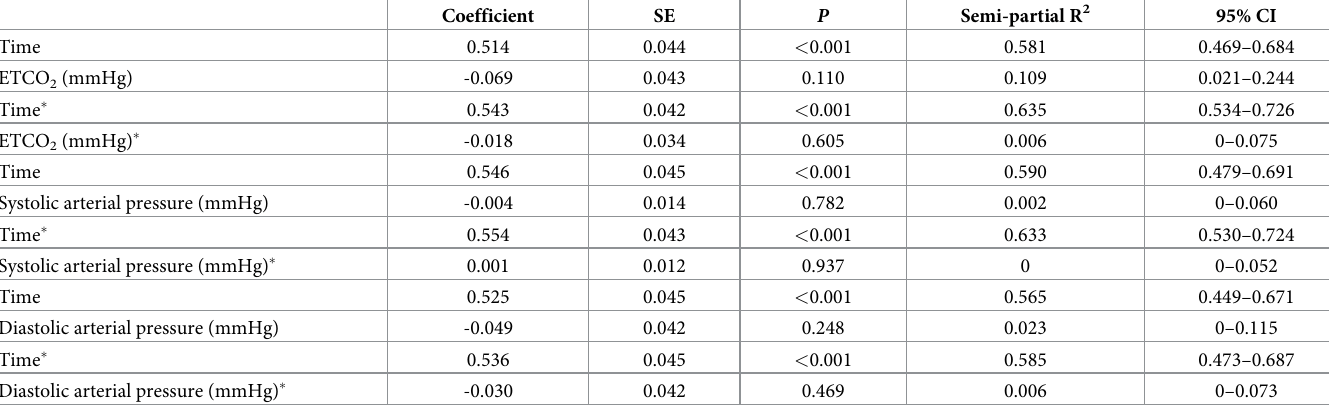
Table 3. Fixed effects of time and hemodynamic parameters on LV wall thickness in mixed effect models.